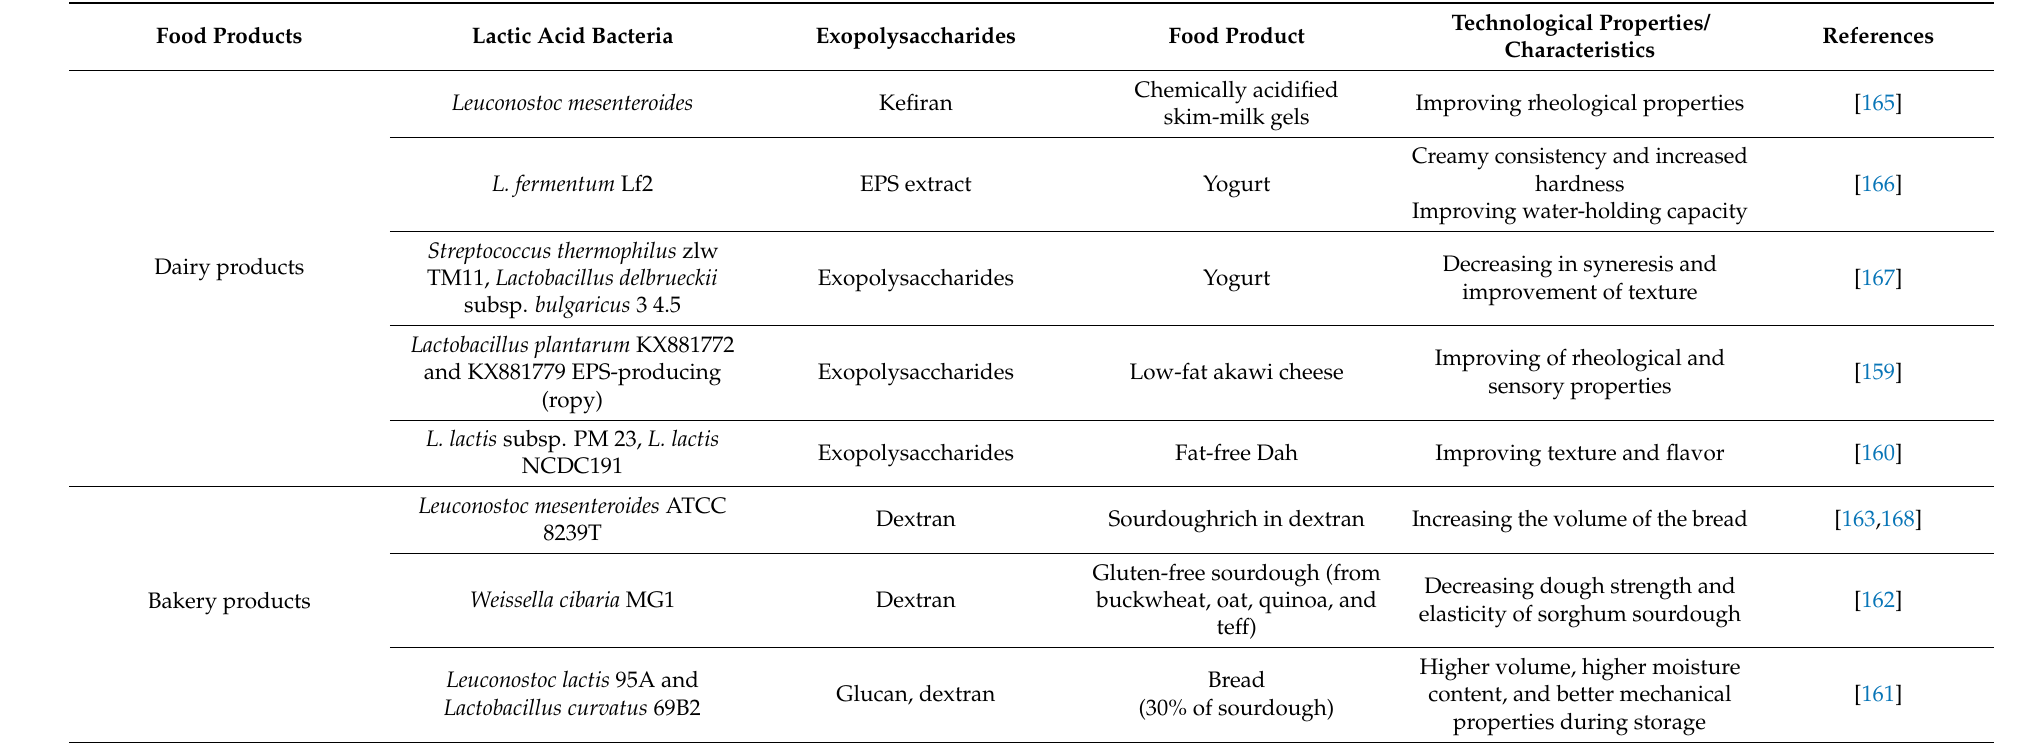
Table 4. Applications of EPS produced by lactic acid bacteria in